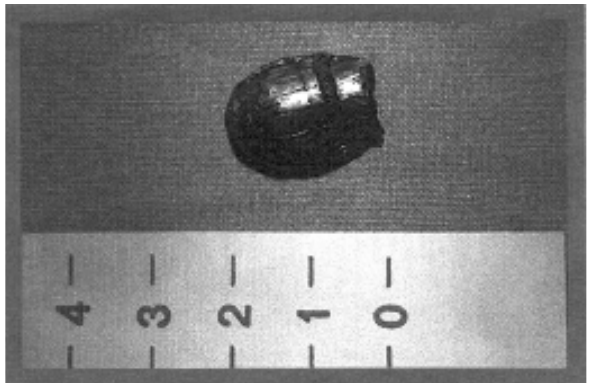
Fig. 3 - Bala de calibre 38 extraída do ventrículo direito e septo